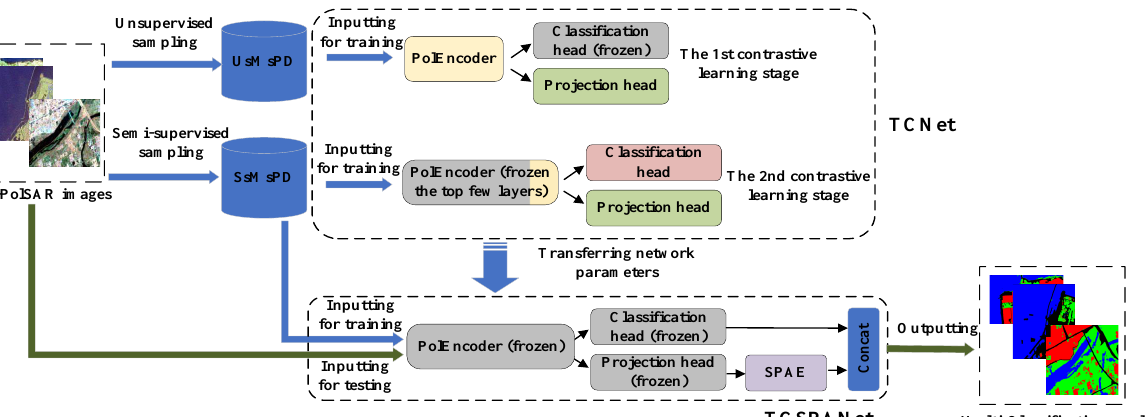
Figure 1. Overall framework. Before training, two patch-level datasets UsMsPD and SsMsPD are built from multi-PolSAR images. The proposed TCSPANet is gradually constructed and trained by using the two datasets. First of all, the TCNet is trained on the UsMsPD and SsMsPD. Next, the SPAE is attached to the trained TCNet to get the final model TCSPANet, which is trained using the samples of SsMsPD. When testing, one trained TCSPANet model can give the classification results of multi-PolSAR